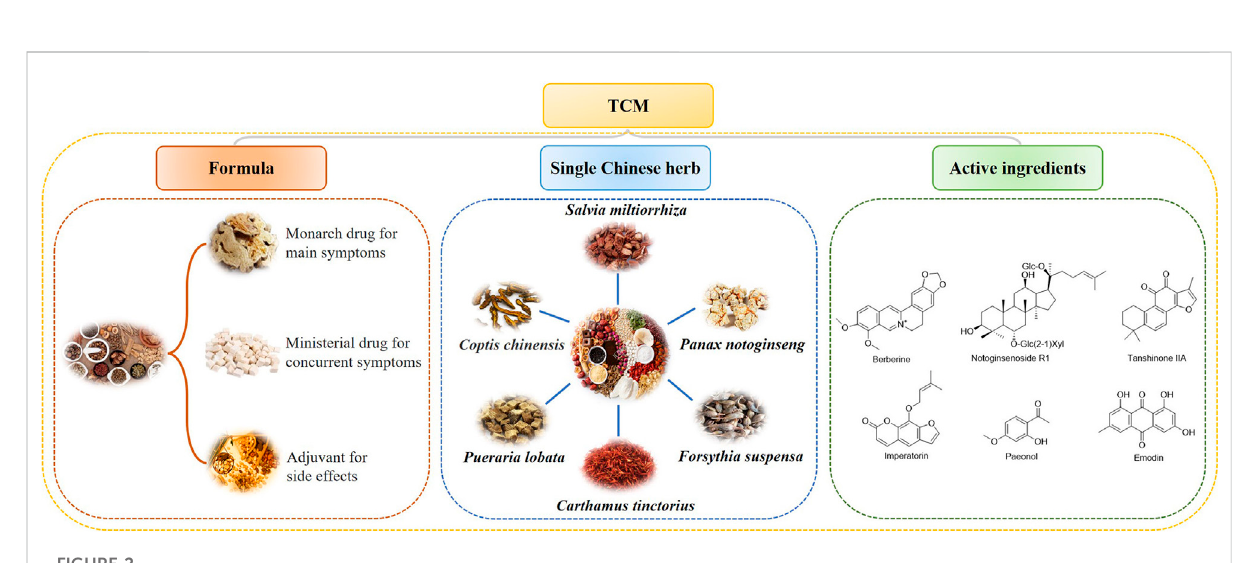
FIGURE 2 TCM formulas, single Chinese herbs, and active compounds that protect the heart from